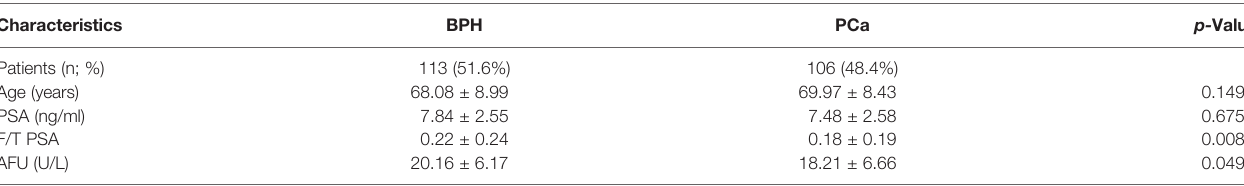
TABLE 1 | Clinical characteristics of PCa and BPH patients. Characteristics BPH PCa p- Value Patients (n;